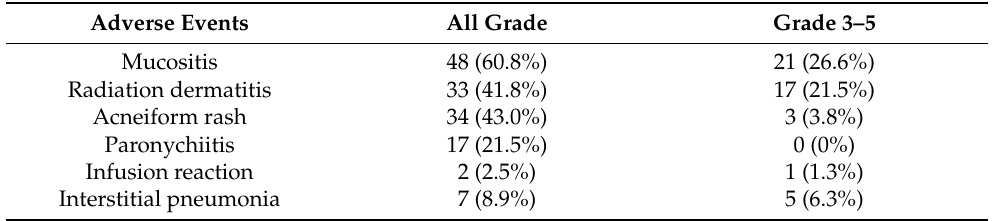
Table 4. Adverse